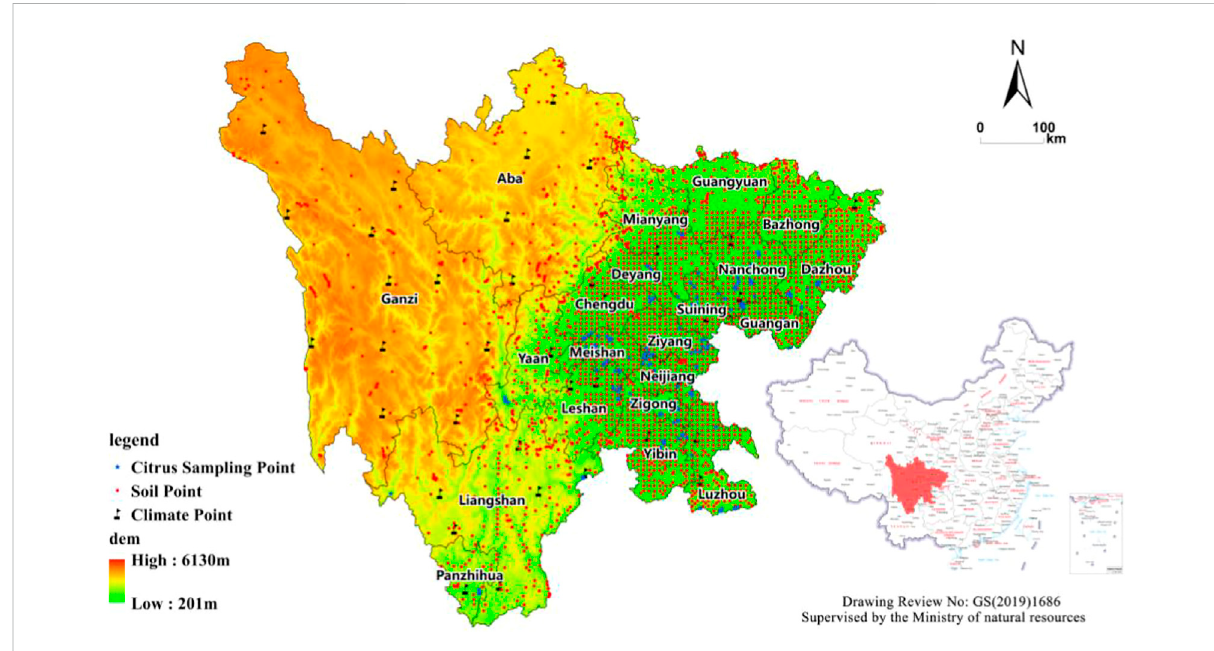
FIGURE 1 Geographical location of Sichuan Province and data